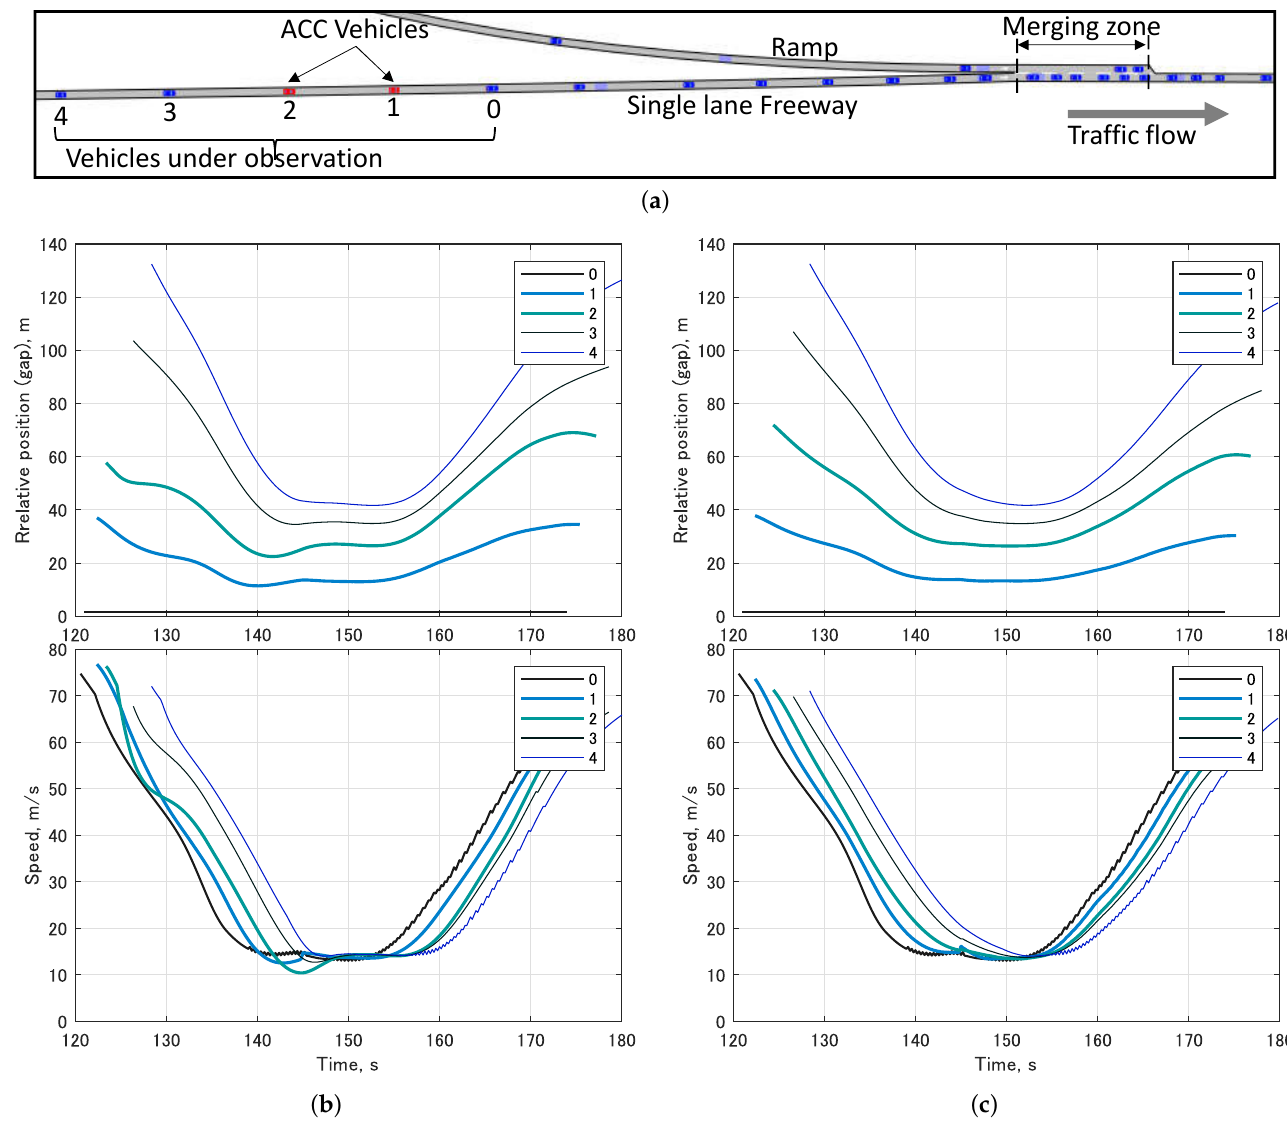
Figure 6. ( a ) Initial positions of the observed vehicles in the simulator. Performances of five vehicles when vehicles 1 and 2 are driven by ( b ) ACC and ( c ) La-ACC. In both cases, speed of vehicle 0 remains the same.